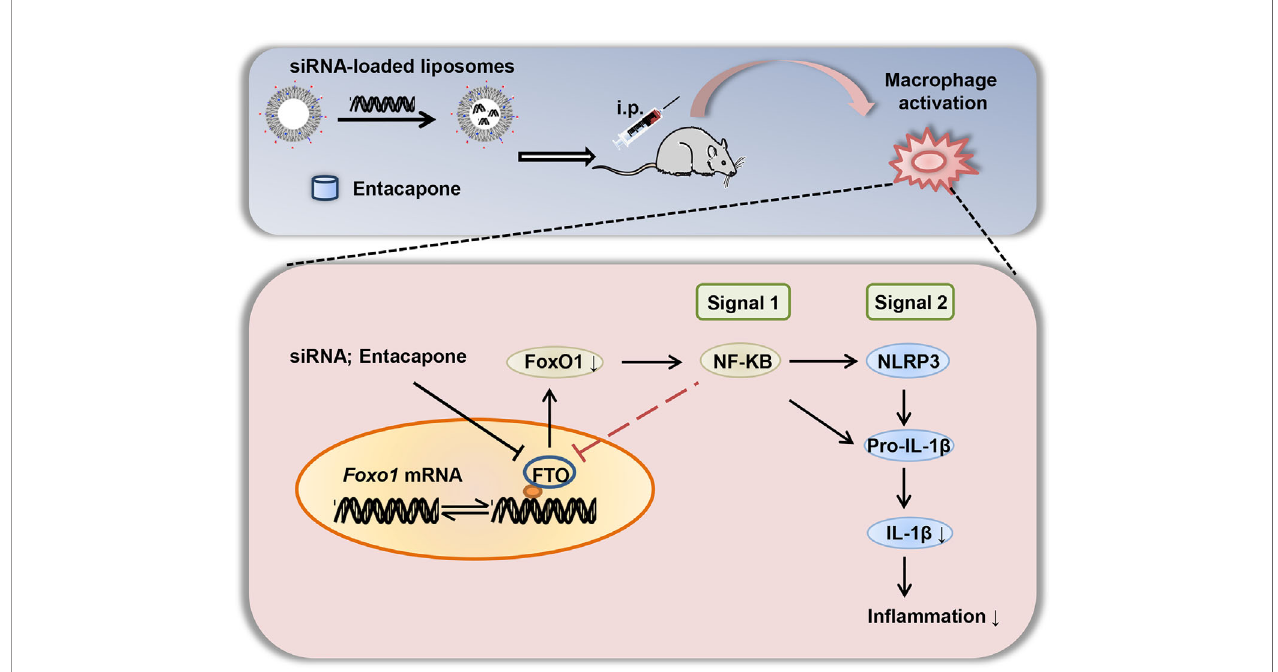
FIGURE 9 | A diagram shows that targeted inhibition of FTO demethylase protects against LPS-induced septic shock by suppressing NLRP3 in fl